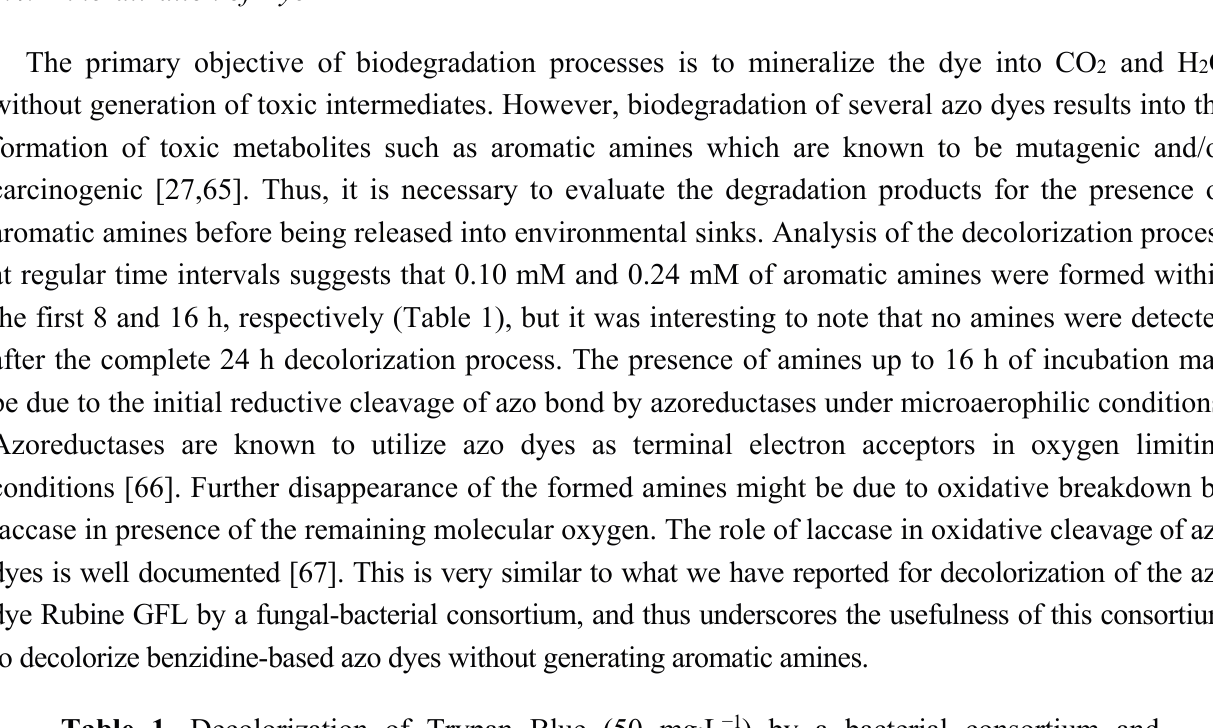
Table 1. Decolorization of Trypan Blue (50 mg·L − 1 ) by a bacterial consortium and formation of aromatic amines at regular time of